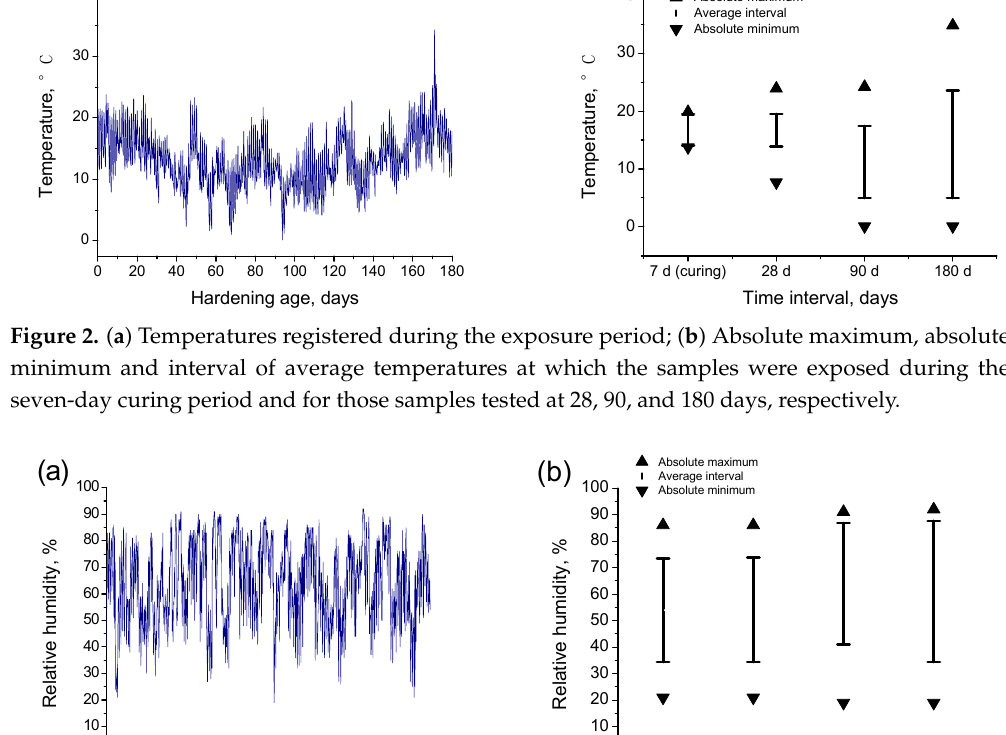
which covered values between 20% and close to 90%.